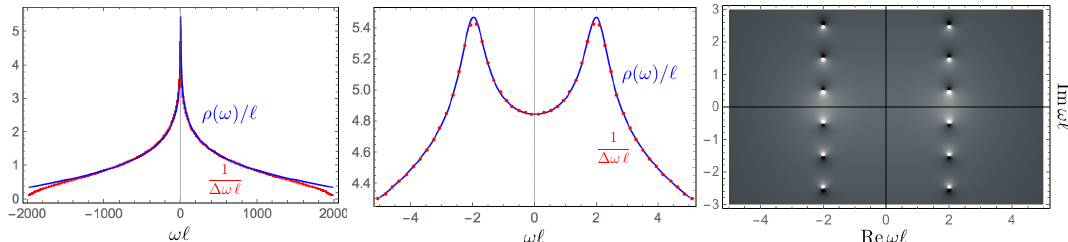
Figure 3 . Regularized dS 2 scalar mode density with ν = 2 , Λ uv ‘ ≈ 4000 . Blue line = Fourier P ψ (cid:0) 1 transform of χ : ρ ( ω ) /‘ = 2 log(Λ ) − 1 ± iν ± iω‘ ) . Red dots = inverse eigenvalue bulk uv ‘ π 2 π 2 spacing of numerically diagonalized 4000 × 4000 matrix H in globally truncated model (appendix B.2). Rightmost panel = | ρ ( ω ) | on complex ω -plane, with quasinormal mode poles at ω‘ = ± i ( 1